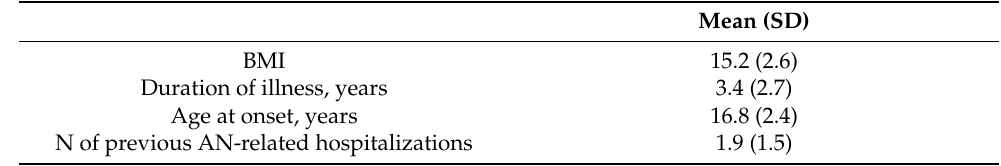
Table 1. Clinical variables of inpatients with anorexia nervosa (AN).